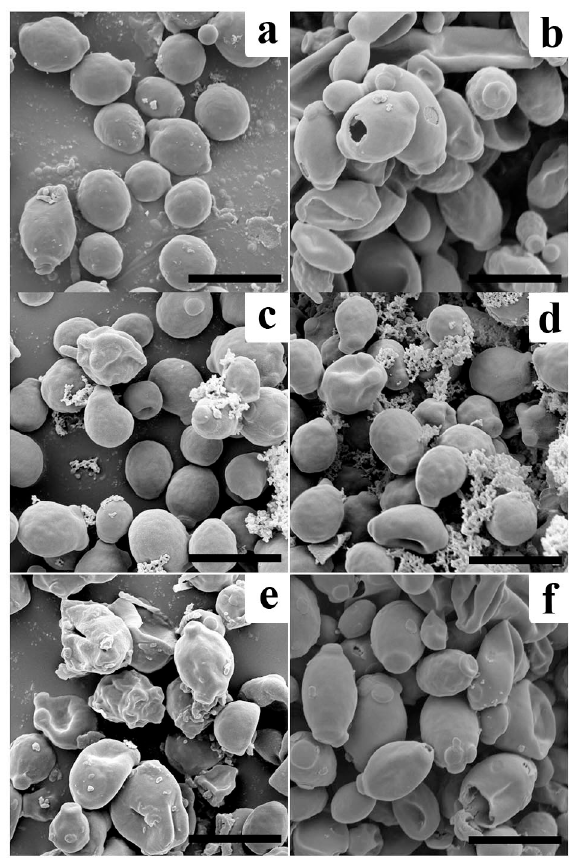
Figure 5. Morphological changes of C. albicans cells with proteins in pH 5.2. ( a ): control, ( b ): melittin (37.5 µ g / mL), ( c ): Trx-H2 (300 µ g / mL), ( d ): H3 (37.5 µ g / mL), ( e ): 2N3C (75 µ g / mL), and ( f ): 3N2C (18.8 µ g / mL). Scale bar: 5 µm.